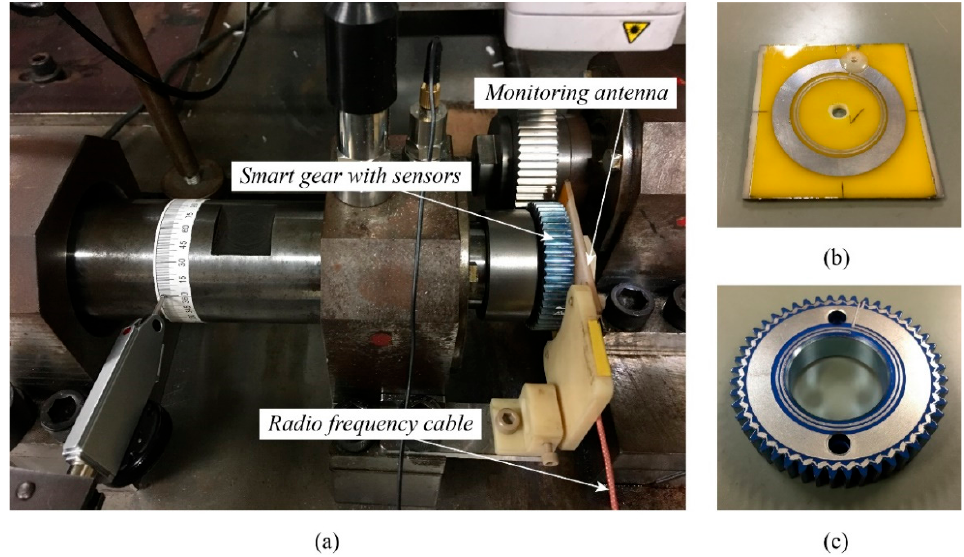
Figure 1. The smart gear health monitoring system: ( a ) practical smart gear health monitoring system; ( b ) monitoring antenna; ( c ) smart gear